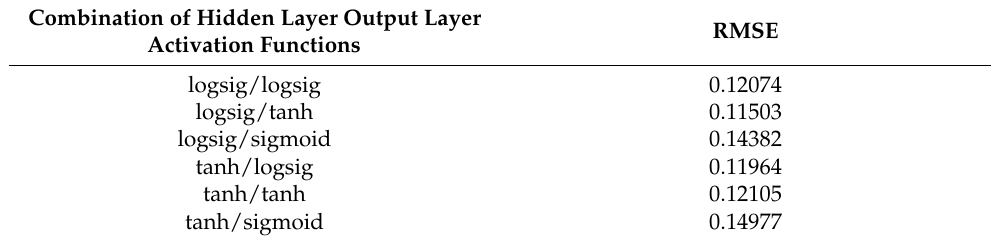
Table 3. Activation function optimization.